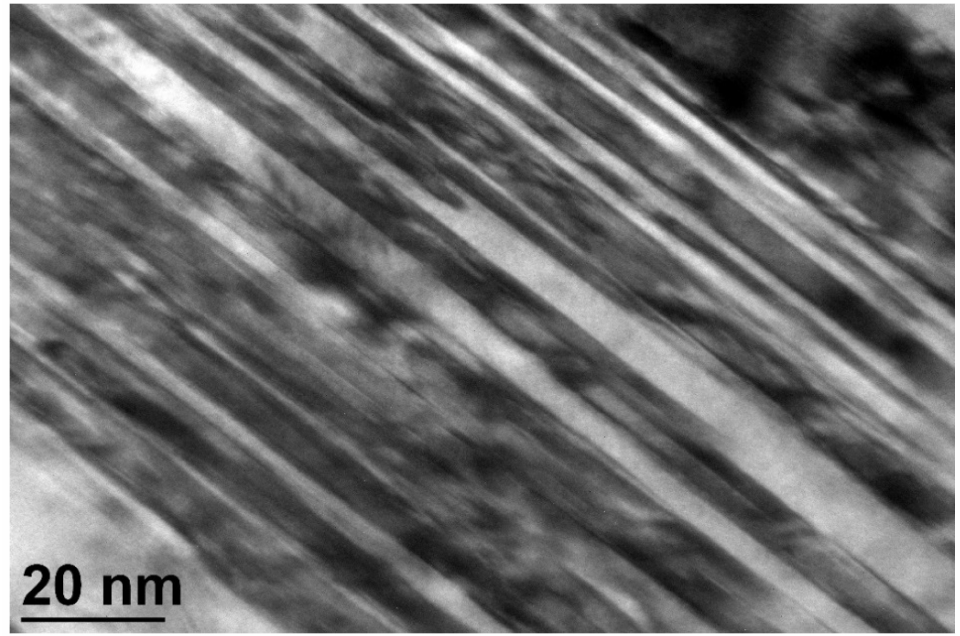
Figure 4. HRTEM image of a fine bainitic microstructure of KAB steel showing individual bainitic ferrite plates. When observed in bright field mode, the bainitic ferrite plates ( α ) appeared light, and the retained austenite ( γ )